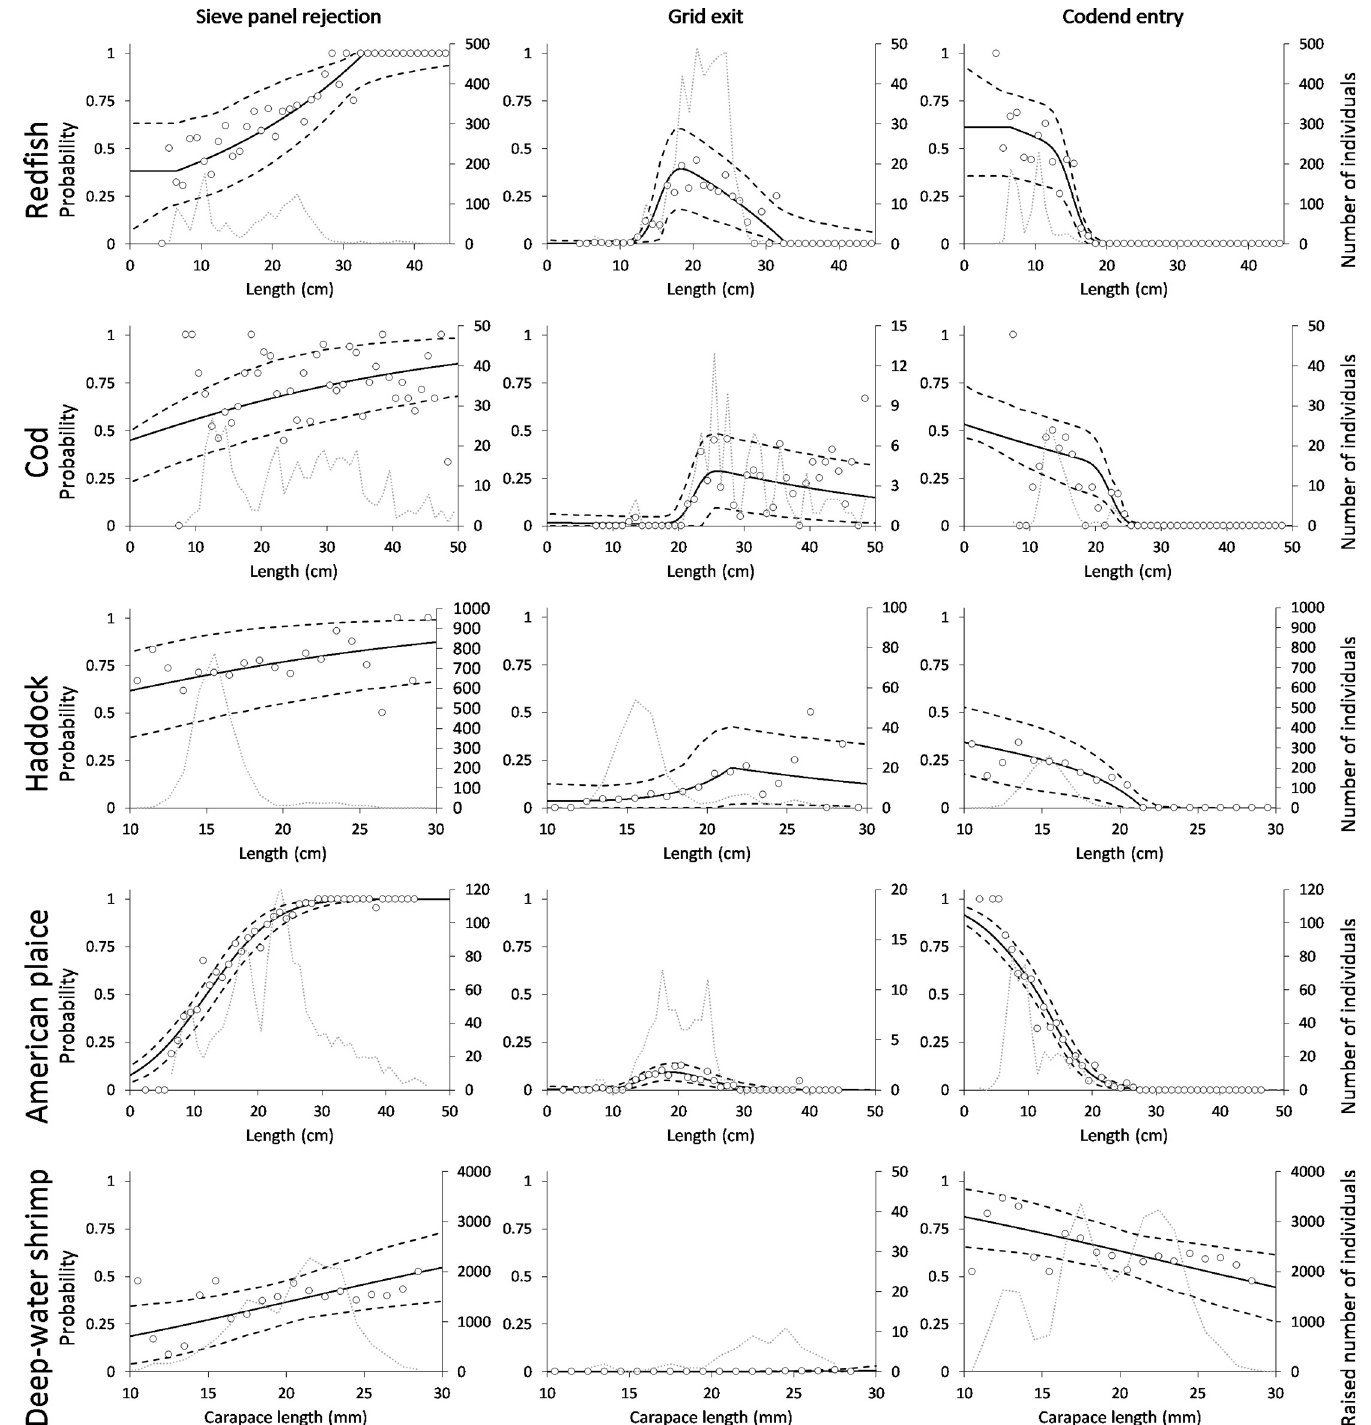
Fig 4. Modelling of the length-dependent observed experimental release and retention rates. Left column: release share to sieve panel cover (sieve panel rejection probability). Centre column: release share to Nordm ø re grid cover (grid exit probability). Right column: catch share to blinded codend (codend entry probability). Data for redfish are shown in the first row, followed by cod, haddock, American plaice and deep-water shrimp in the bottom row. Circle marks represent the observed experimental rate and the solid black curve represents the modelled rate. Black dashed curves represent 95% confidence bands for the modelled rate and the grey dotted curve represents the observed experimental catch in the specific compartment (sieve panel cover, grid cover and blinded codend).